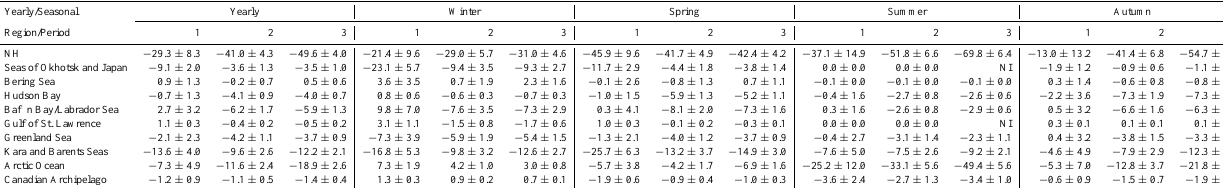
Table 4. Yearly and seasonal Arctic sea ice area trends with estimated standard deviations (10 3 km 2 yr − 1 ) for each of three periods: 1979– 1996 (1), 1979–2006 (2), and 1979–2010 (3). NI means no ice. Values for 1979–1996 are from Parkinson et al. (1999); values for 1979–2006 are from Parkinson and Cavalieri (2008); and values for 1979–2010 are from Table 2 above.